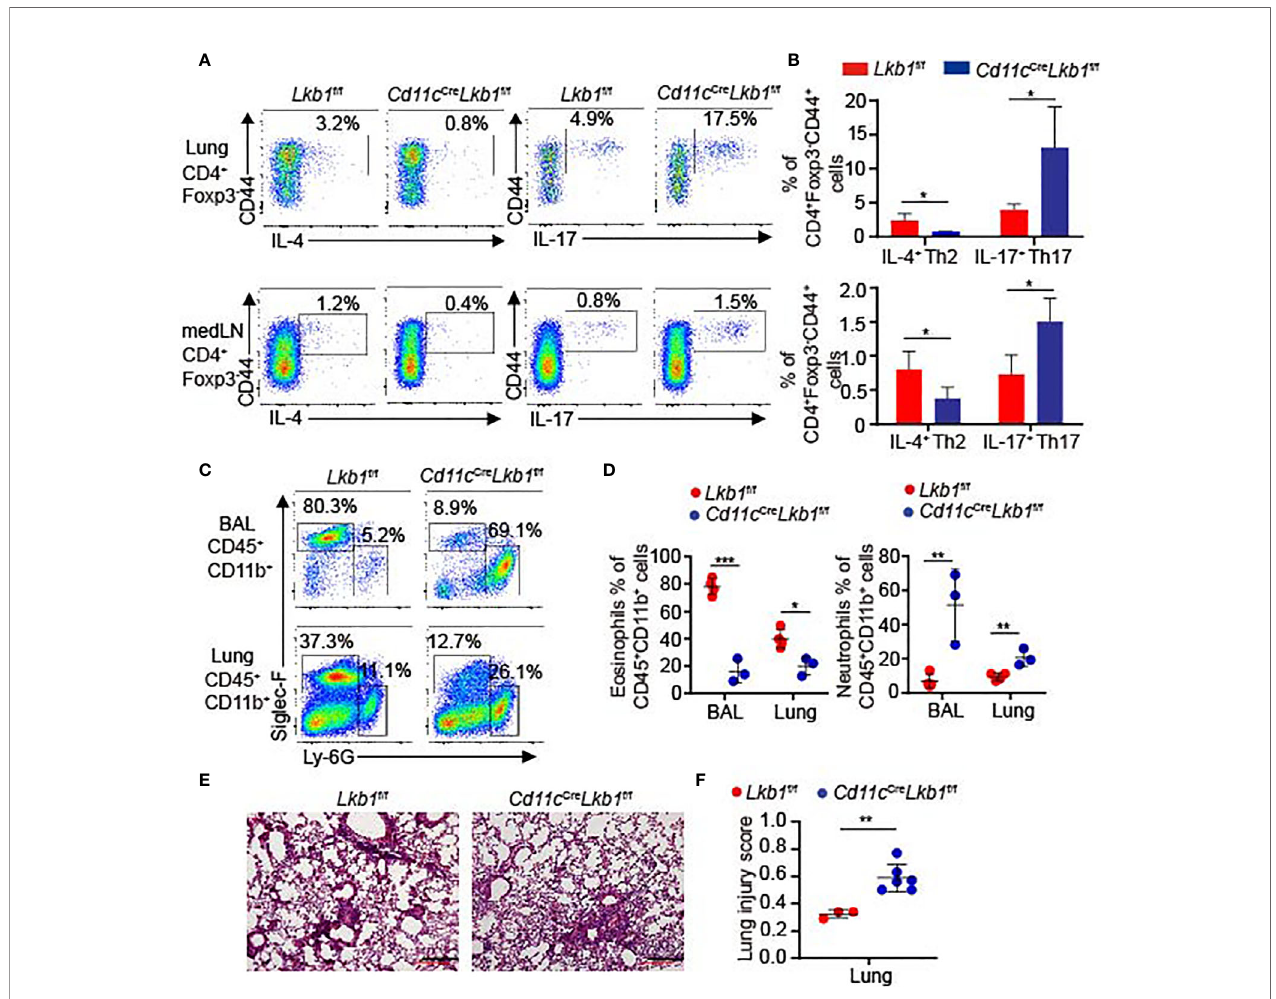
FIGURE 4 | Cd11c Cre Lkb1 f/f mice developed more severe pathology in asthma. (A, B) Flow cytometry analysis (A) and the frequency (B) of CD4 + Foxp3 - CD44 + IL-4 + Th2 cells or CD4 + Foxp3 - CD44 + IL-17 + Th17 cells in the lung and medLNs from Lkb1 f/f and Cd11c Cre Lkb1 f/f mice intranasally challenged with HDM allergens (n = 3 – 4). (C) Flow cytometry analysis of eosinophils (CD45 + CD11b + Siglec-F + ) and neutrophils (CD45 + CD11b + Ly6G + ) in BAL fl uid and lungs from Lkb1 f/f and Cd11c Cre Lkb1 f/f mice intranasally challenged with HDM allergen. (D) Quanti fi cation of the percentages of eosinophils and neutrophils in BAL fl uid and lungs from Lkb1 f/f and Cd11c Cre Lkb1 f/f mice intranasally challenged with HDM allergen (n = 3 – 4). (E) Images show histopathological sections of lungs from Lkb1 f/f and Cd11c Cre Lkb1 f/f mice intranasally challenged with HDM allergen and stained with hematoxylin and eosin (scale bar, 100 m m). (F) The lung injury score was evaluated blindly by two independent investigators (n = 3 – 6). Each symbol (D, F) represents a mouse, and results are presented as the mean ± S.D., * P < 0.05, ** P < 0.01, *** P < 0.001, (by Student ’ s t -test) (B, D, F) . All data represent at least three independent